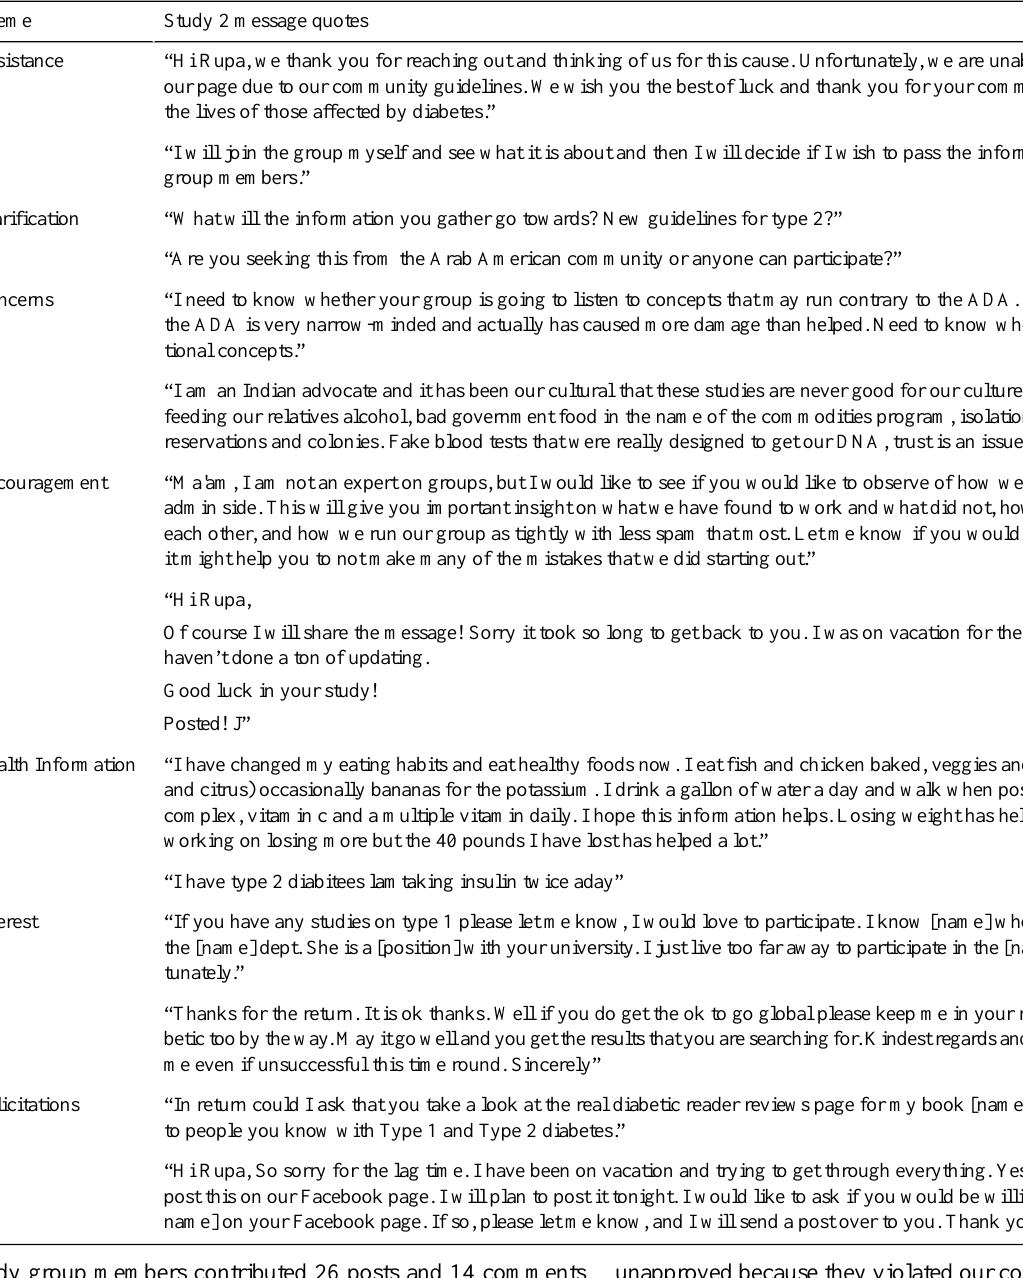
Table 5. Study 2 messages